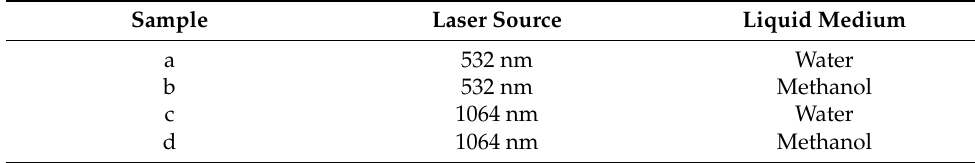
Table 1. Types of samples studied in this